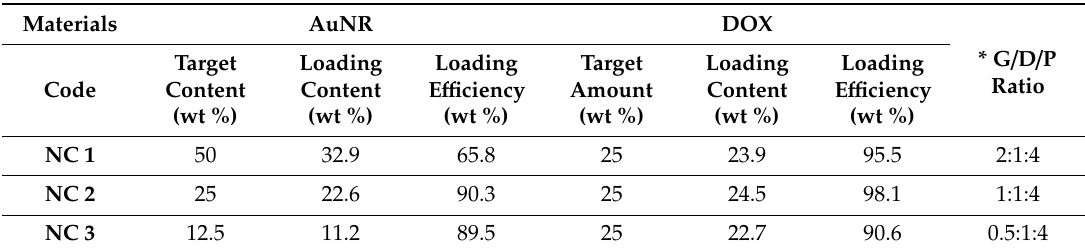
Table 1. Drug loading profile of